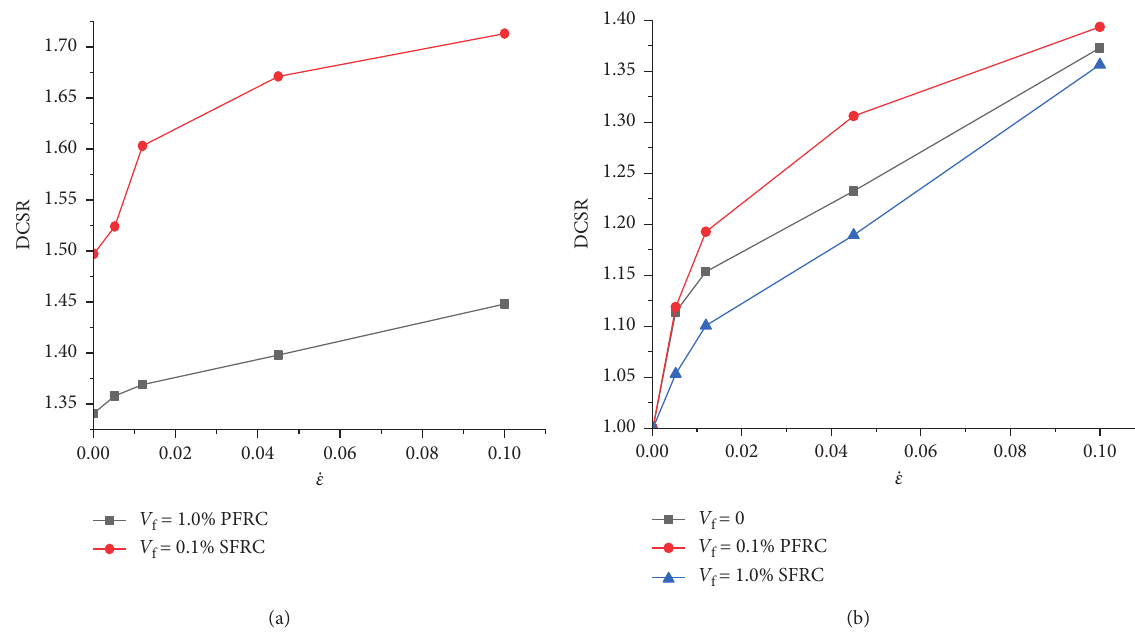
Figure 11: The variation of compressive strength with strain rate: (a) the variation of compressive strength ratio with strain rate relative to plain concrete; (b) the variation of compressive strength ratio with strain rate relative to FRC at _ ε � 1 . 45 × 10 − 4